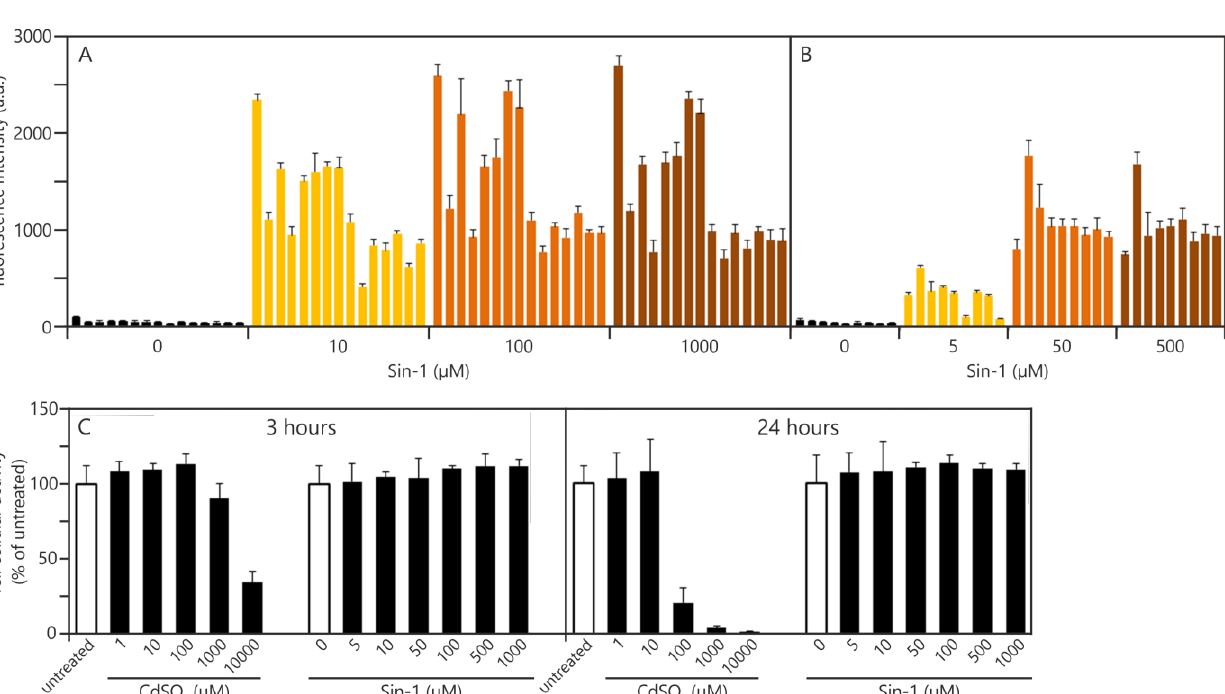
Figure 3. Absolute values for detecting reactive oxygen species (ROS): After one hour of H DCF-DA loading, A549 cells were treated for three hours with different concentrations 2 of Sin-1. Arbitrary fluorescence values after blank subtraction are shown. Each bar represents the mean of three technical replicates of an independent experiment and corresponding standard deviations. ( A ) 15 independent experiments using 10, 100 and 1000 µM Sin-1; ( B ) Nine additional independent experiments using reduced Sin-1 concentrations (5, 50, 500 µM); ( C ) Sin-1 concentrations used show no sign of toxicity in A549 cells. Cells were treated for three and 24 hours with the indicated Sin-1 concentrations. CdSO served as the chemical reaction control at both time points and 4 induced dose- and time-dependent